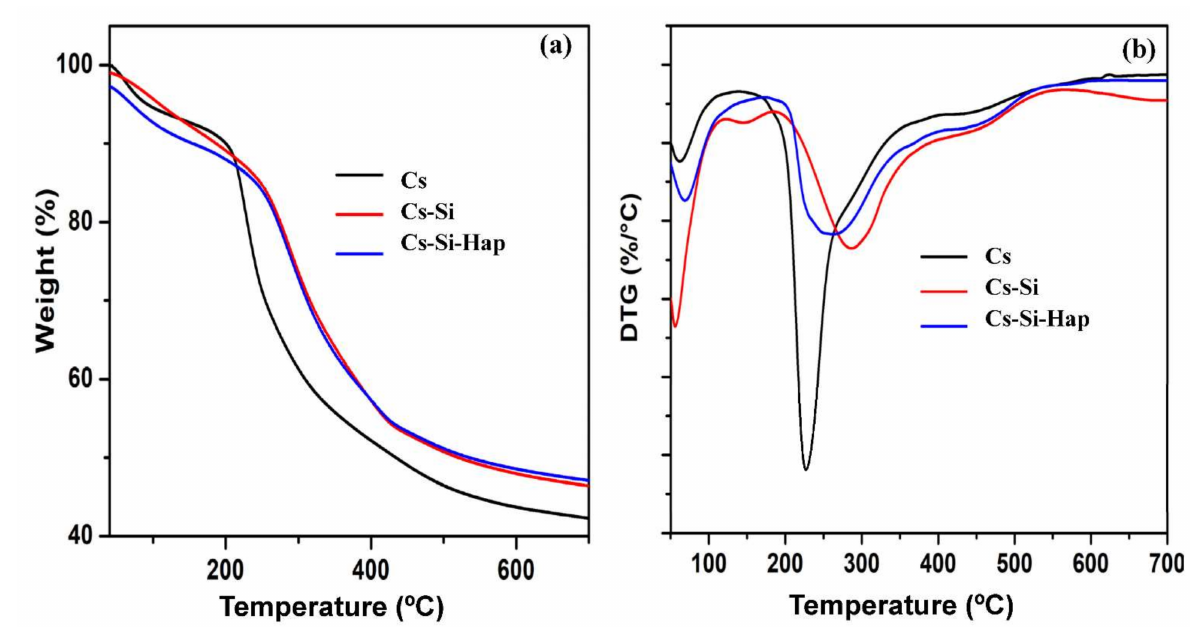
Figure 4. TGA ( a ), and DTG ( b ) analysis plots of Cs and Cs based